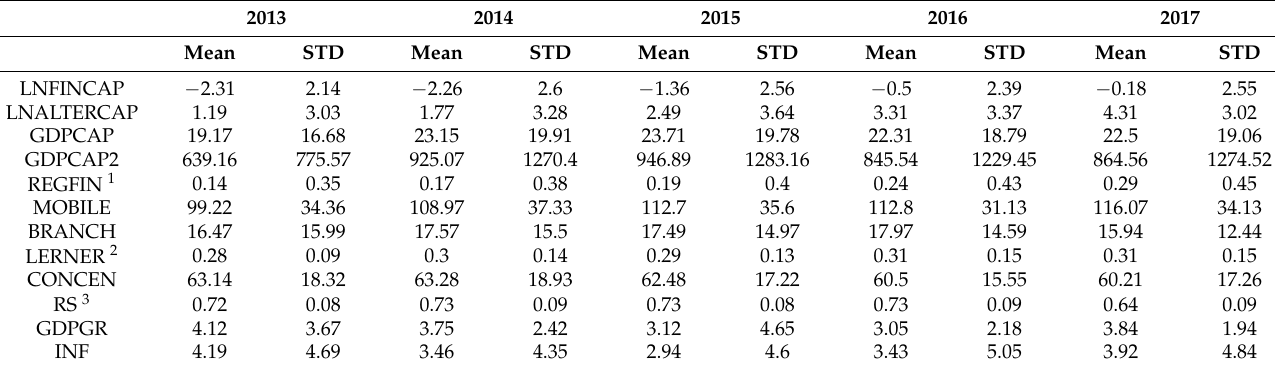
Table A3. Descriptive statistics of variables used in the second-stage